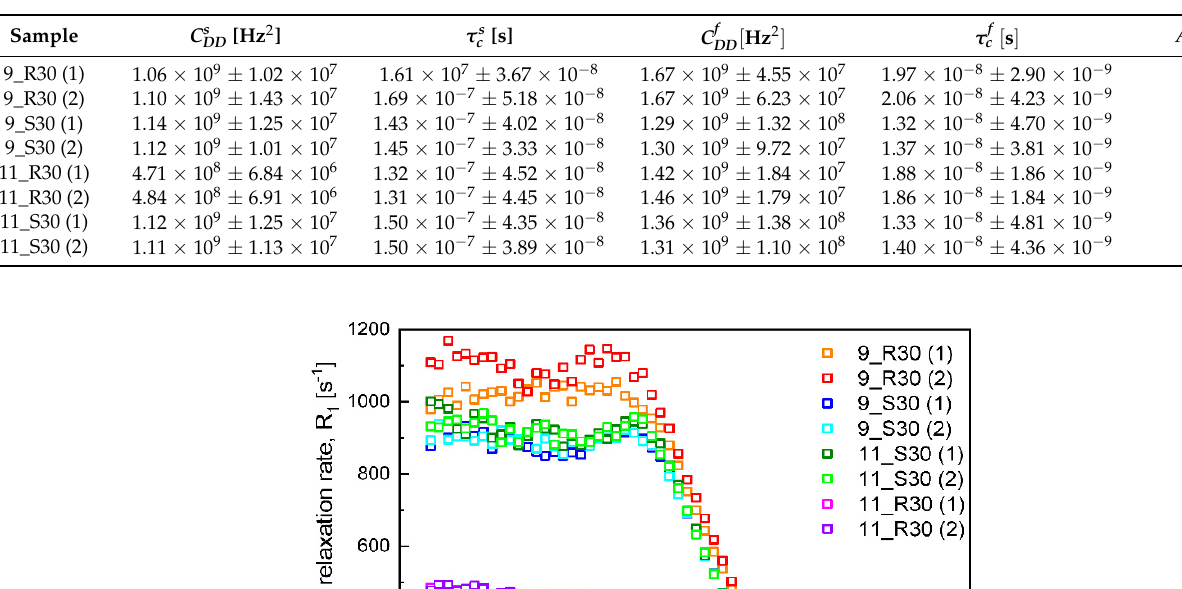
Table 1. Parameters obtained from the analysis of the relaxation data in terms of Equation (2).